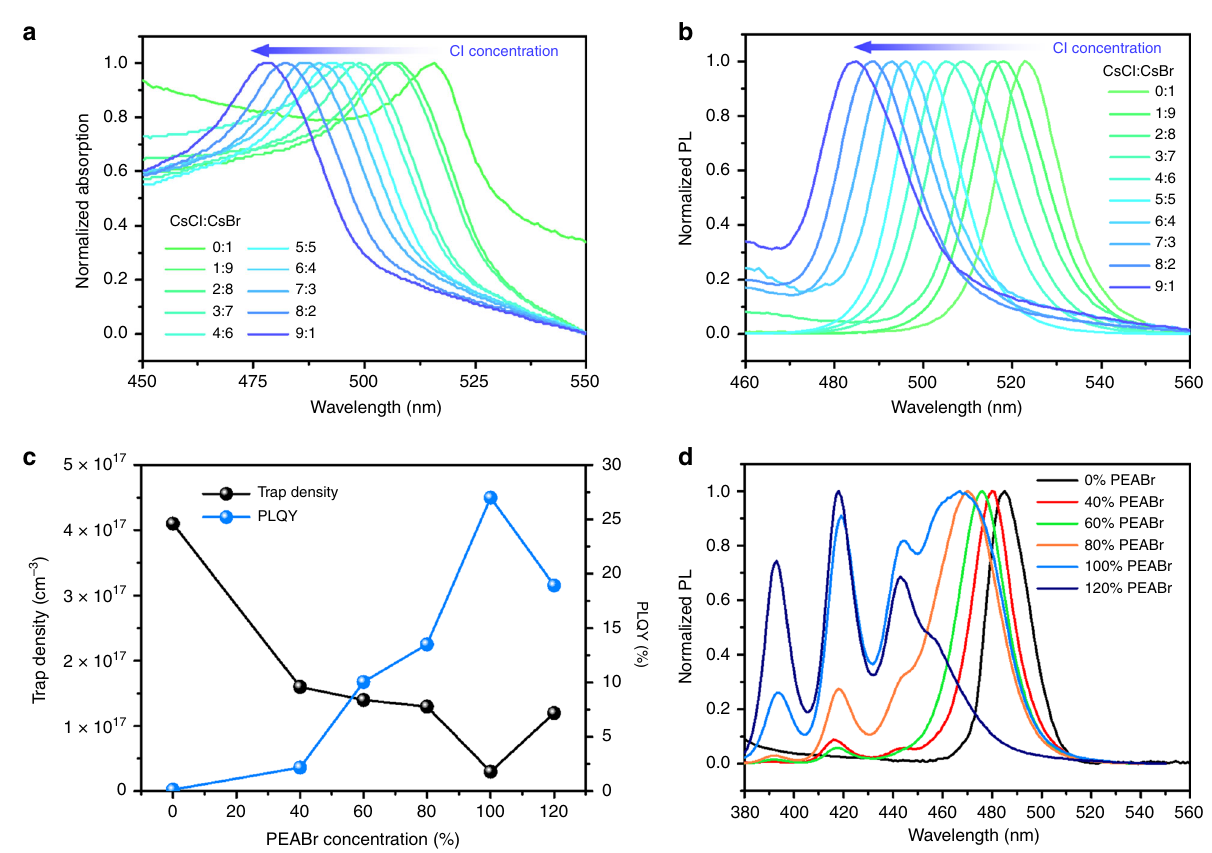
Fig. 1 Composition engineering for ef fi cient blue emission of perovskite. a Normalized absorption of CsPbCl x Br 3 − x thin fi lms with different molar ratios of cesium chloride (CsCl) to cesium bromide (CsBr). The results are normalized by the intensity of their corresponding excitonic absorption peaks. b Photoluminescence (PL) spectra of CsPbCl x Br 3 − x thin fi lms with different molar ratios of CsCl to CsBr. c Trap densities and photoluminescence quantum yields (PLQYs) of CsPbCl 0.9 Br 2.1 thin fi lms with different ratios of phenylethylammonium bromide (PEABr). The trap density was calculated based on